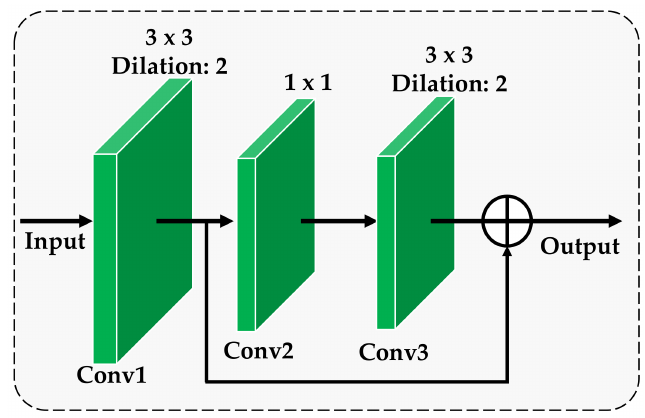
Figure 2. The architecture of the residual block.